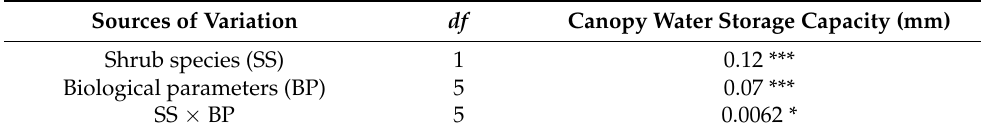
Table 4. Analysis of variance for the effects of shrub species and biological parameters on canopy water storage capacities ( n =